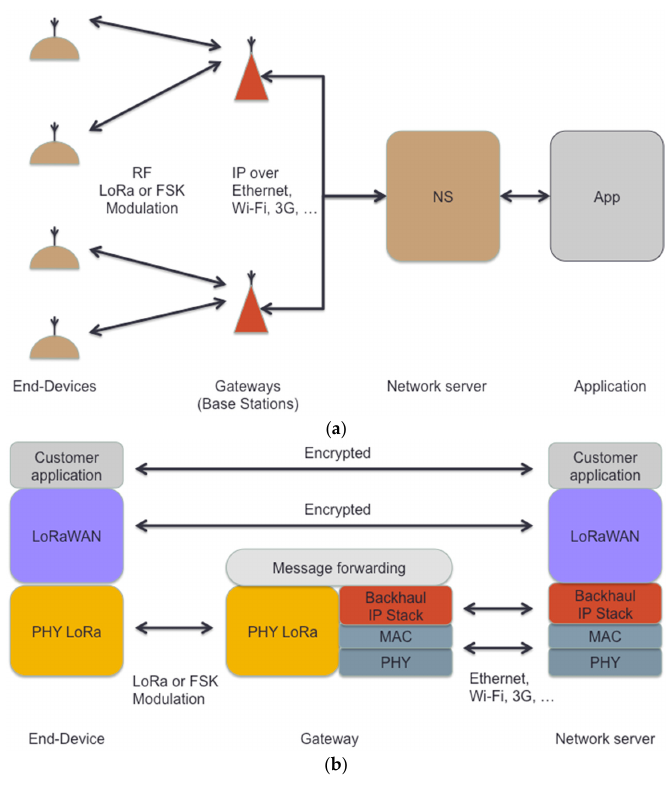
Figure 1. LoRaWAN ( a ) system and ( b ) protocol architecture.